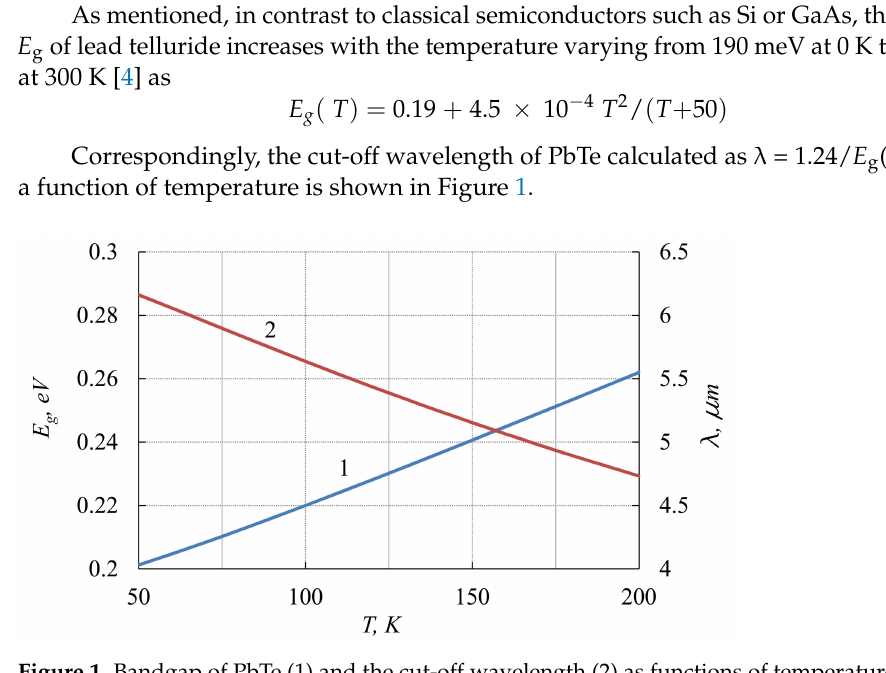
Figure 1. Bandgap of PbTe (1) and the cut-off wavelength (2) as functions of